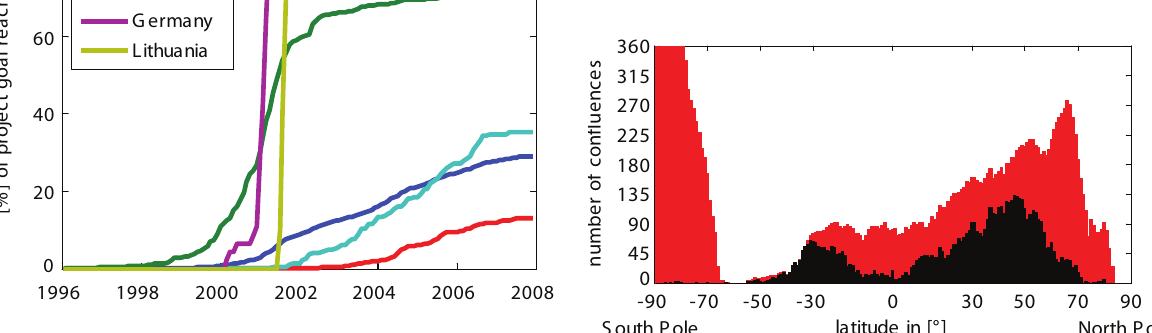
Fig. 9. Visited confluences (top) and light pollution (bottom) created by the U.S. National Oceanic and Atmospheric Administration